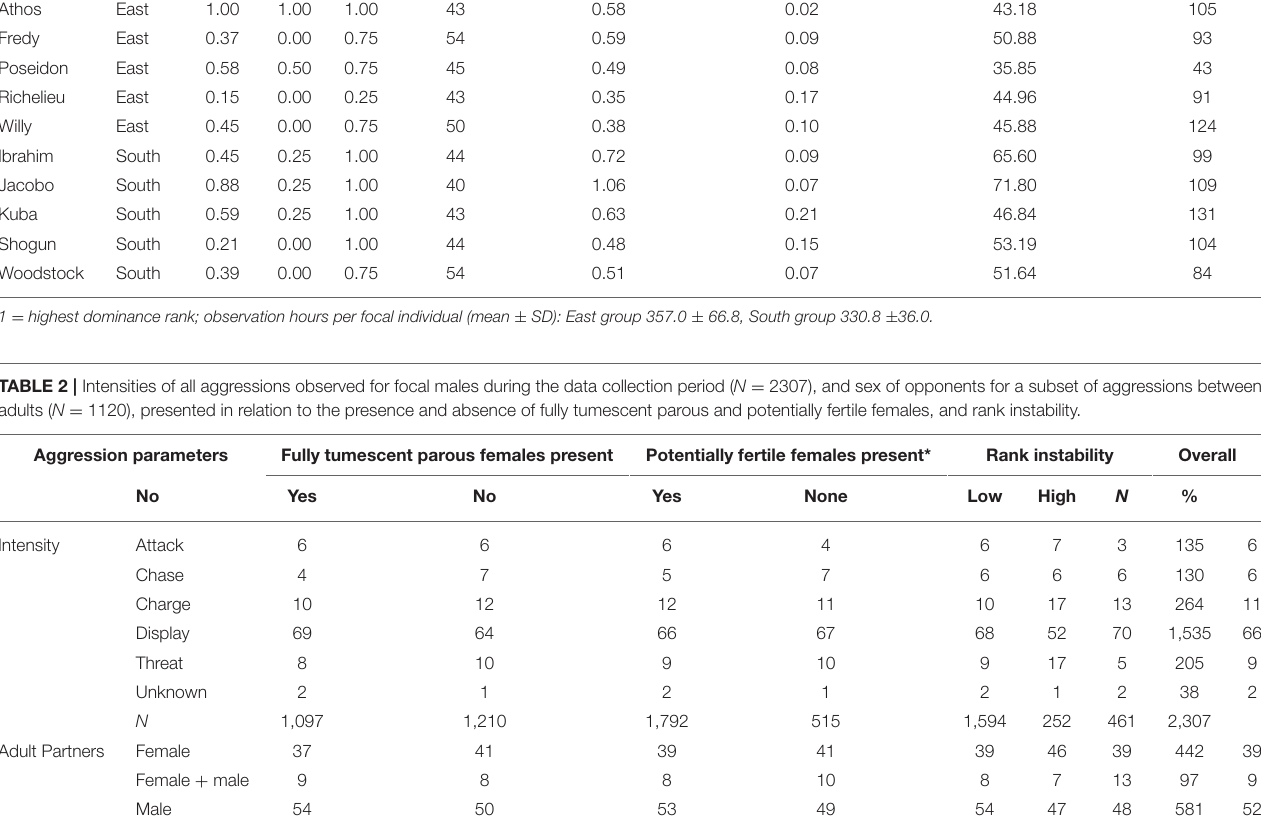
TABLE 1 | Dominance rank, number of focal days and urine samples, aggression rates given and received, and average male chimpanzee urinary cortisol levels per focal individual. Focal ID Group Urine samples